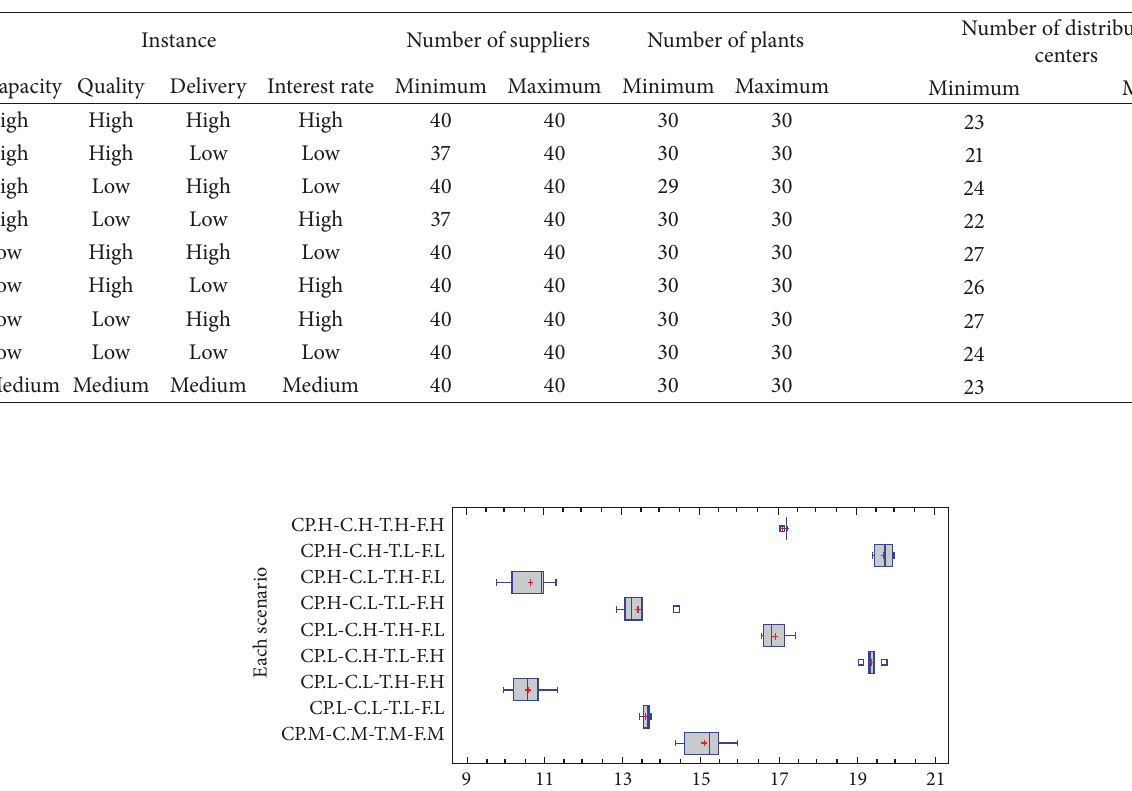
Table 9: Number of facilities used per echelon and scenario.